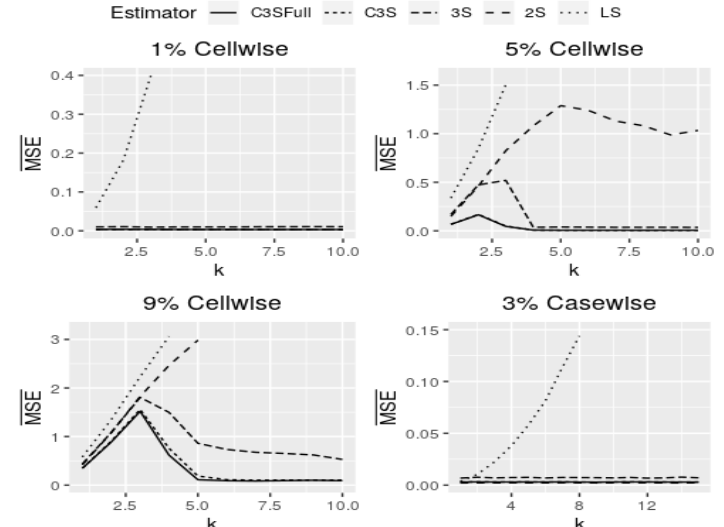
Figure 4. MSE for indicated cell-wise and case-wise contamination values k in models with continuous and dummy covariates, and n = 500. Source: the authors.